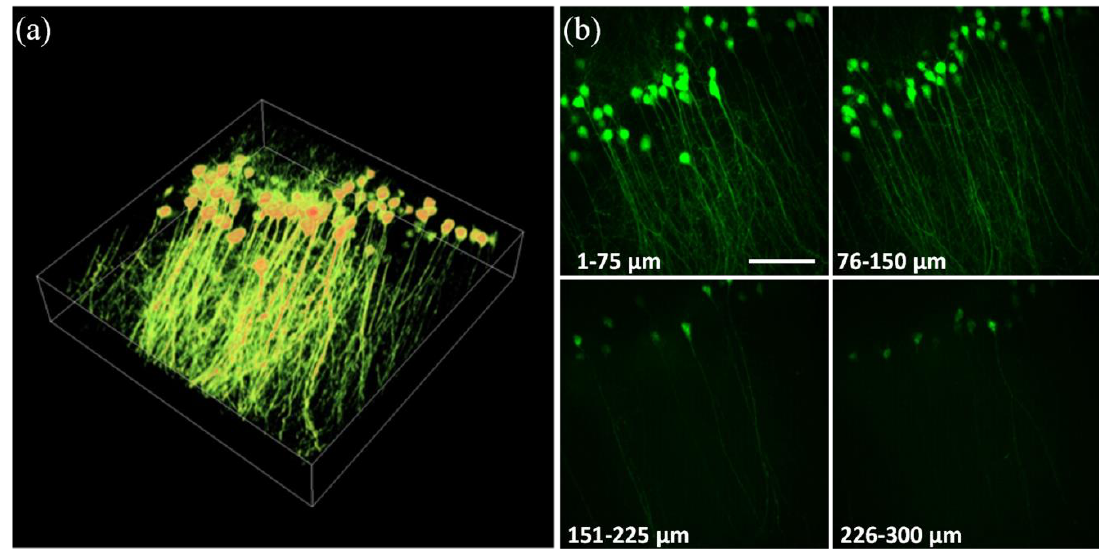
Figure 6. Volumetric imaging of the cleared brain tissue section. ( a ) Three-dimensional image of the cleared brain tissue section. ( b ) MIP of different stack of the captured volume, scale bar: 100 µm.